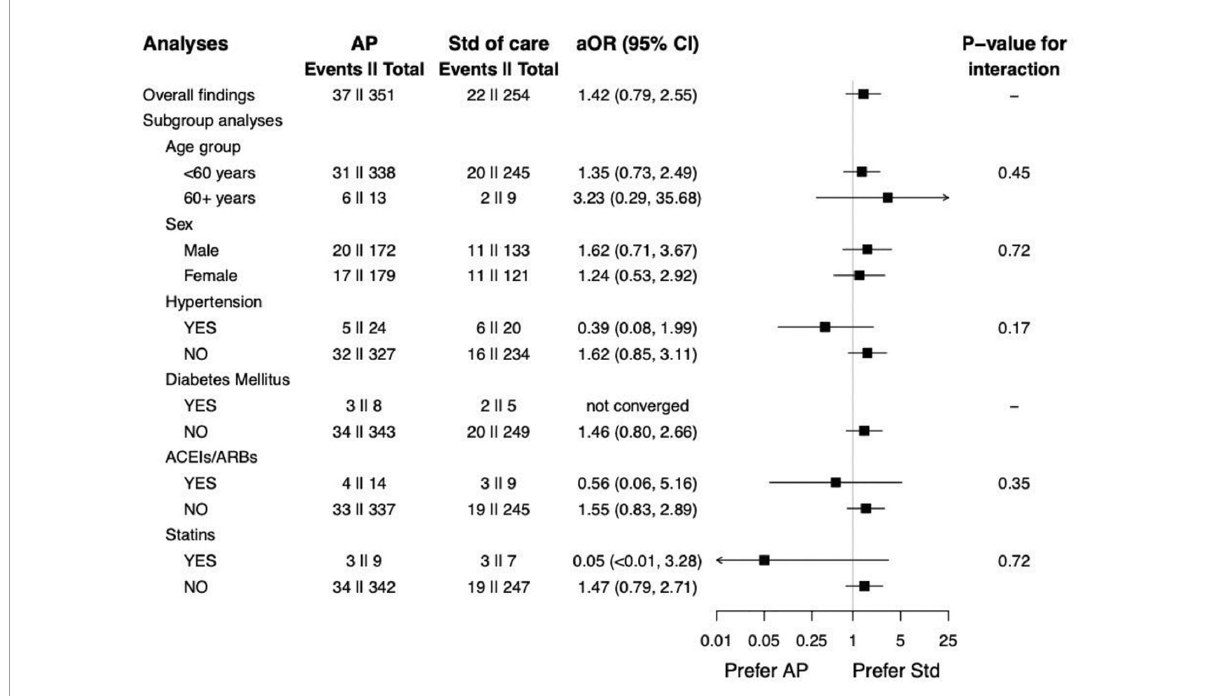
FIGURE2 Subgroup analysis of Andrographis paniculata and the occurrence of